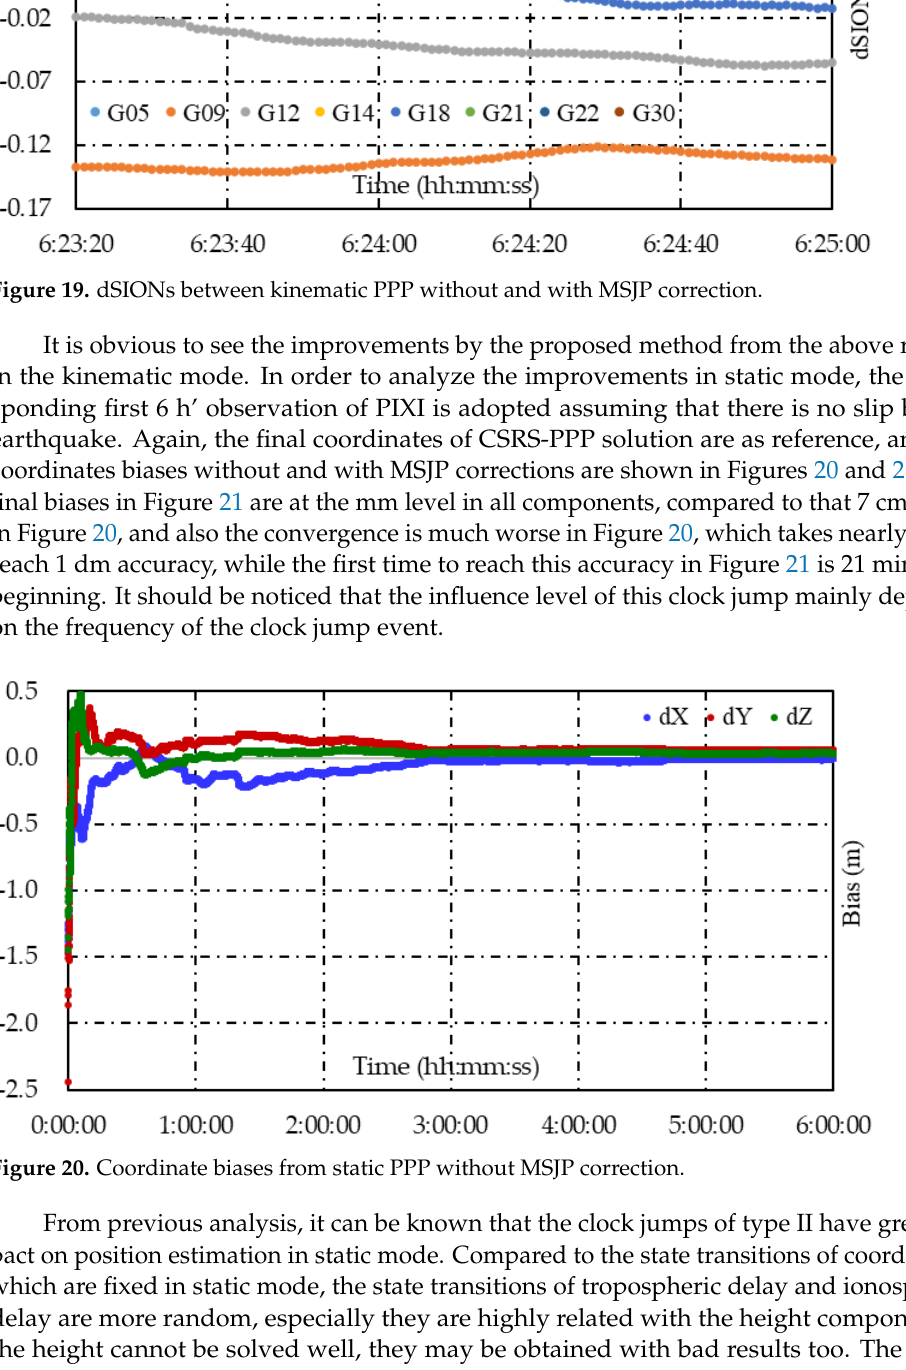
Figure 18. ZTDs from kinematic PPP with and without MSJP corrections.